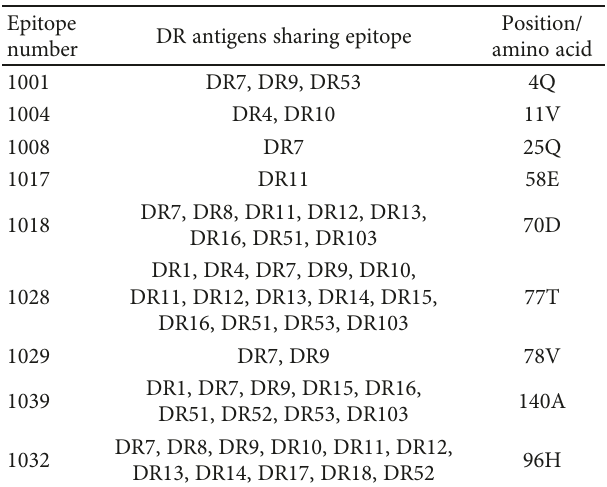
Figure 10: Epitope 6002 shared by MICA antigens MICA ∗ 001 , 002, 004, 007, 009, 012, 018, and 027 and de fi ned by glutamine (Q) at position 91. Table 6: Partial list of HLA class II DR epitopes de fi ned based on aa acid sequence of the beta chain of the antigens. Complete list in supplemental fi le.